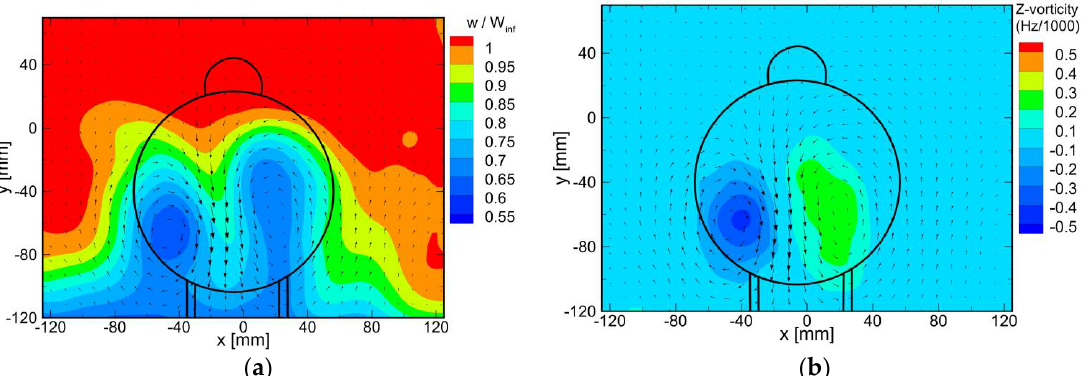
Figure 6. Time-averaged streamwise velocity component ( a ) and streamwise vorticity component ( b ) at z/D = 2 for nose rotation of 20°.